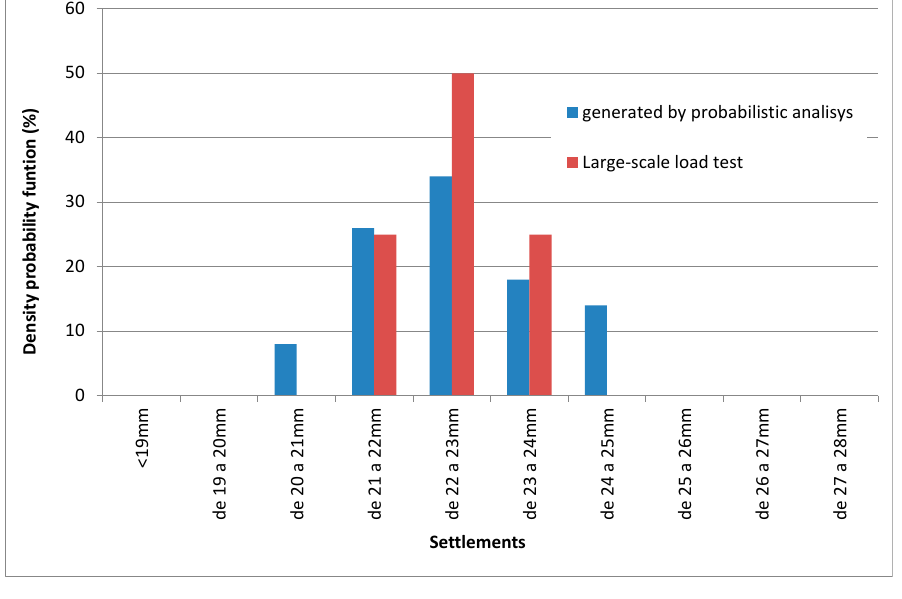
Figure 15. Settlement distribution functions.